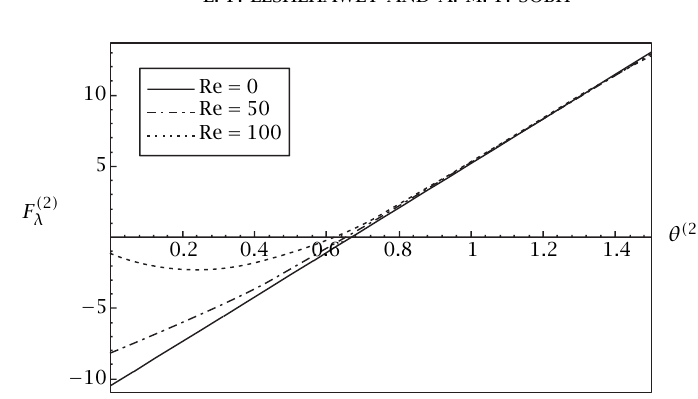
Figure 6.8 . The friction force versus flow rate at Wi = 0, δ = 0 . 02, and ϕ = 0 .